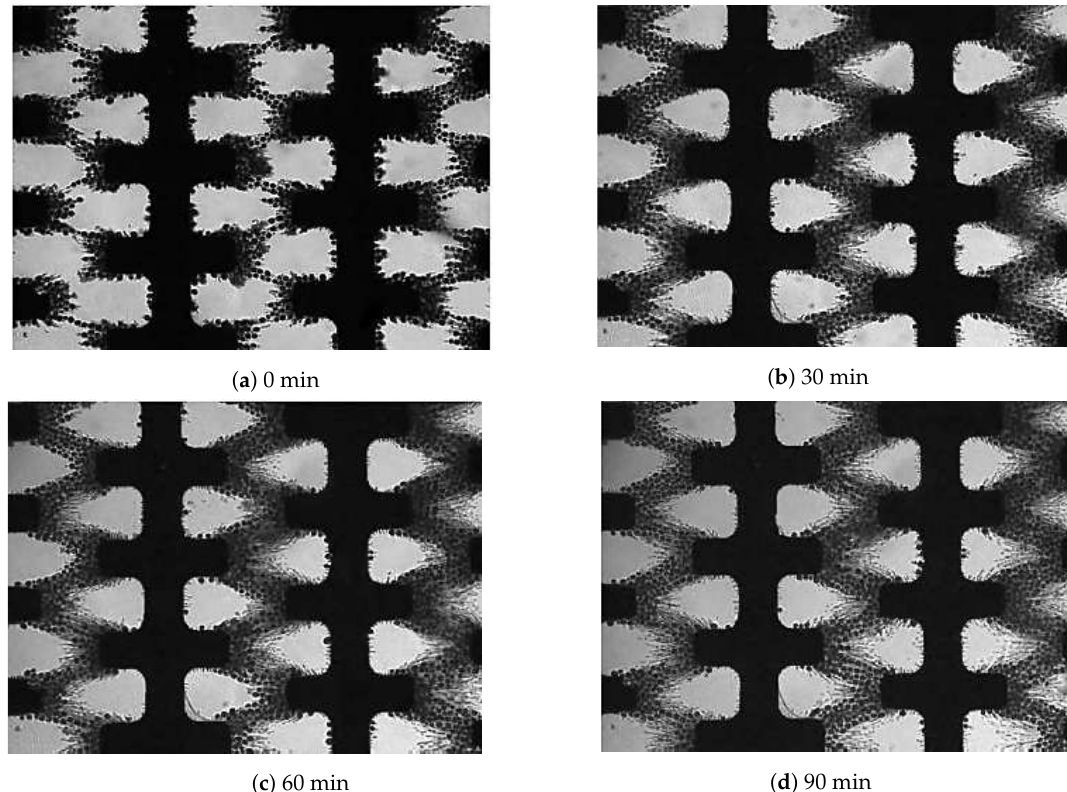
Figure 10. After 60 min of separation time, the mixture of E. coli and S. cerevisiae concentrations were still attracted to the microelectrodes at a low conductivity σ m of 40µS/cm, pulsing time of 12 s and a high fluid flow 9.6 µ L min − 1 . The frequency applied was 1MHz with a voltage of14Vpk-pk. The flow direction was from left to right.